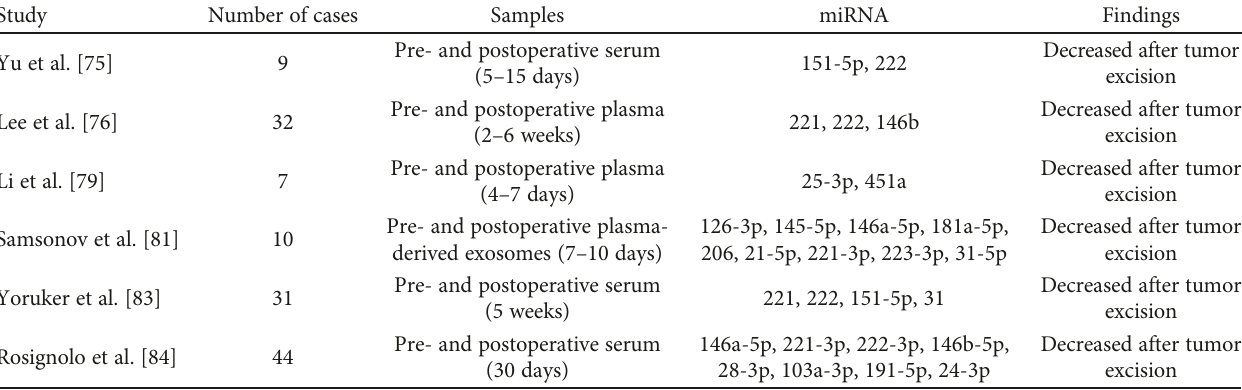
Table 5: Circulating miRNAs as prognostic biomarkers for PTC